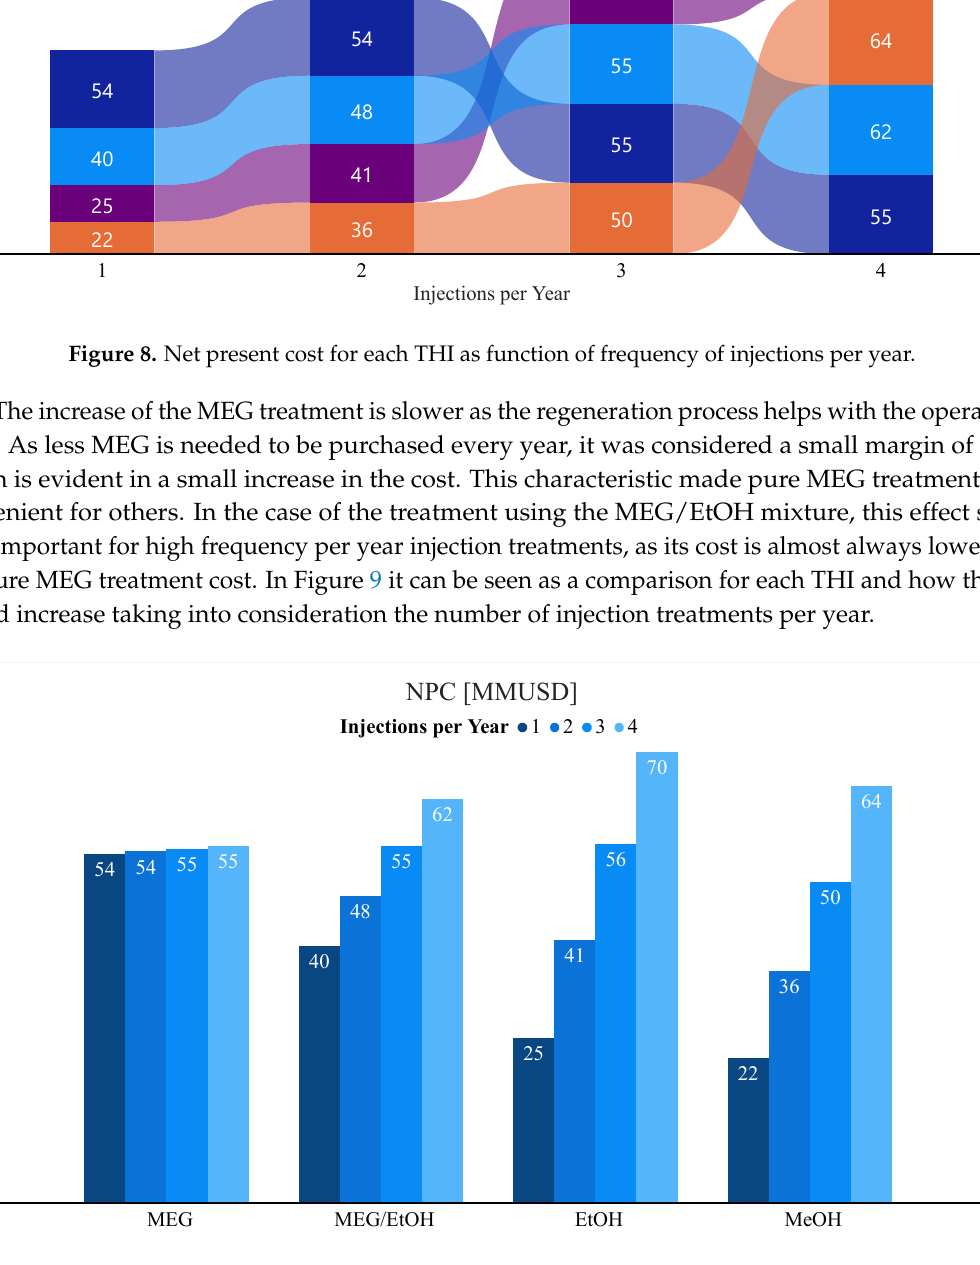
Figure 9. Net present cost Vs Injections per